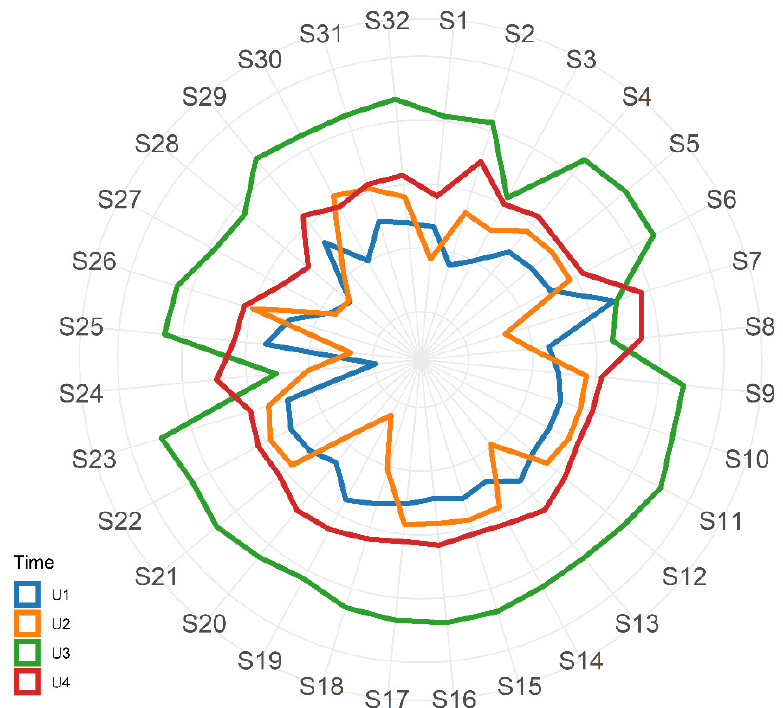
Figure 2. Radar plot with mean values of standardized responses from the 32 eNose nano sensors related to urine samples U1–U4.